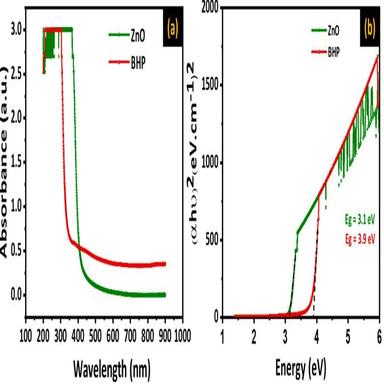
(a) absorbance spectra of the two semiconductors ZnO and BHP, (b) tauc plot of ZnO and BHP.